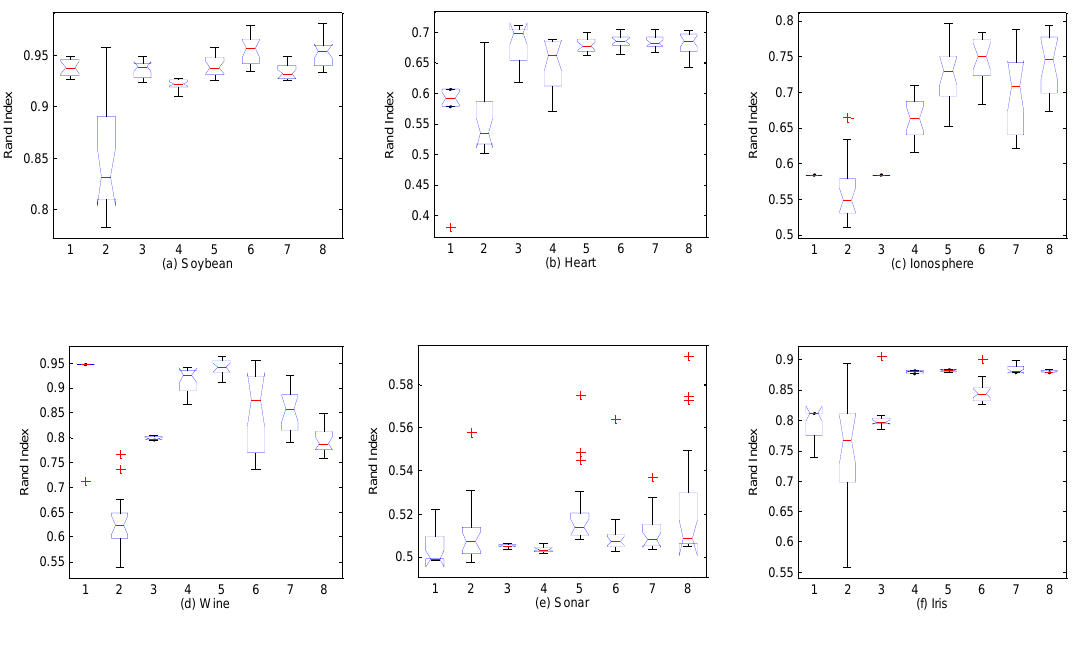
Figure 9. Clustering results of different algorithms for UCI datasets. Algorithms (numbered in Section 4.1) are as follow: (1) Euclidean, (2) RCA, (3) Xing’s, (4) kernel-  , (5) unweighted- S , (6) unweighted- SD , (7) augmented- S , and (8) augmented- SD .